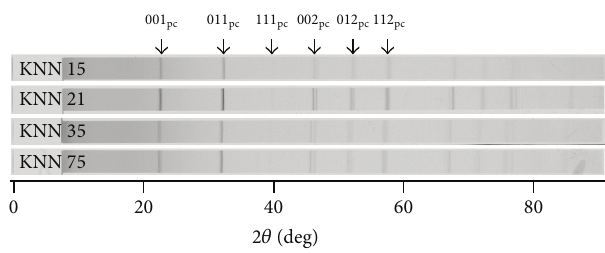
Figure 1: Guinier-H¨agg X-ray diffraction patterns of solid-state reacted KNN, showing only the expected perovskite-related peaks. The subscript “pc” indicates pseudocubic